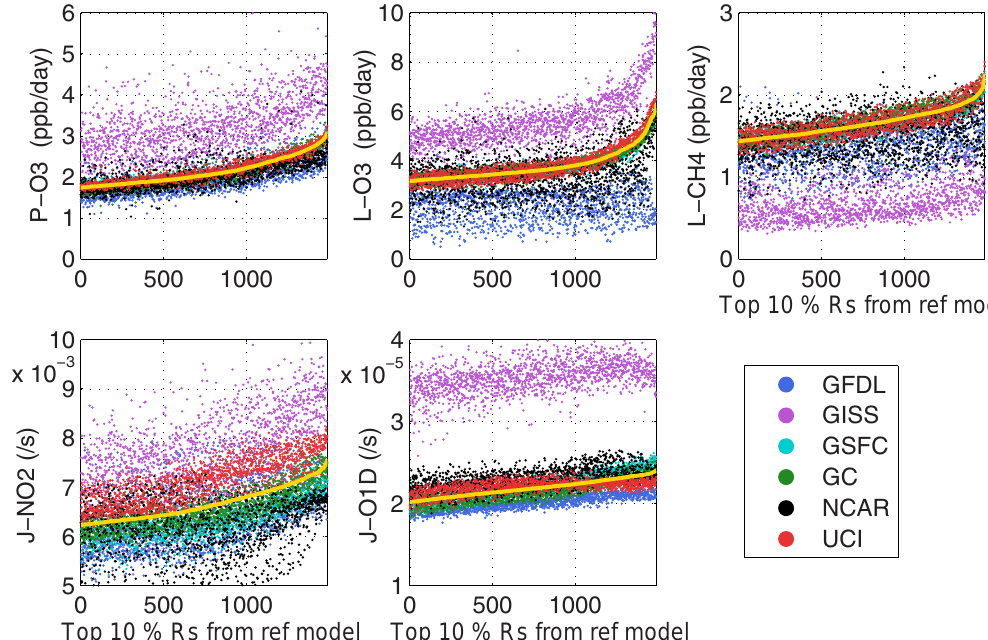
Figure 7. Modeled Reactivity and J -values for 5-day mean parcels plotted using the top-10% in the reference case in ascending order along the x axis. The black dashed monotonically increasing line is the reference case